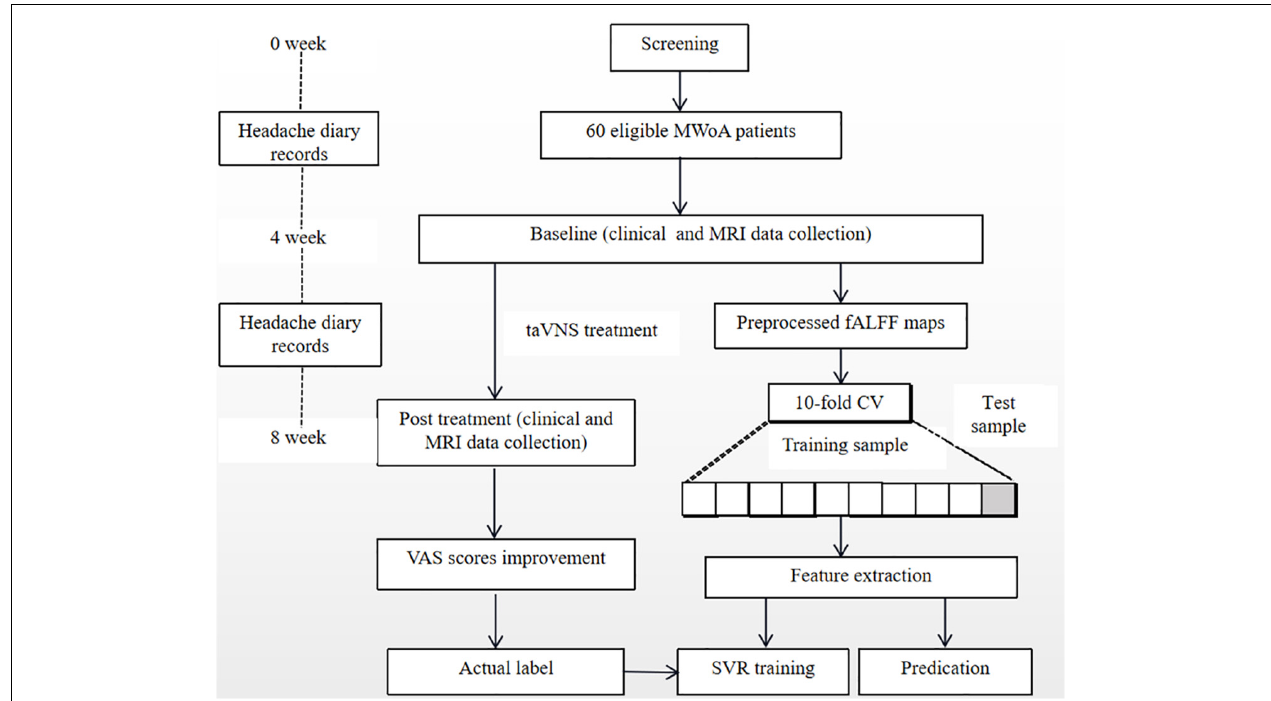
FIGURE 2 | Flowchart of prediction analysis. MWoA , migraine without aura; fALFF, fractional amplitude of low-frequency fluctuation; VAS , visual analog scale; CV , crossvalidation; SVR , support vector regression; taVNS , transcutaneous auricular vagus nerve stimulation.